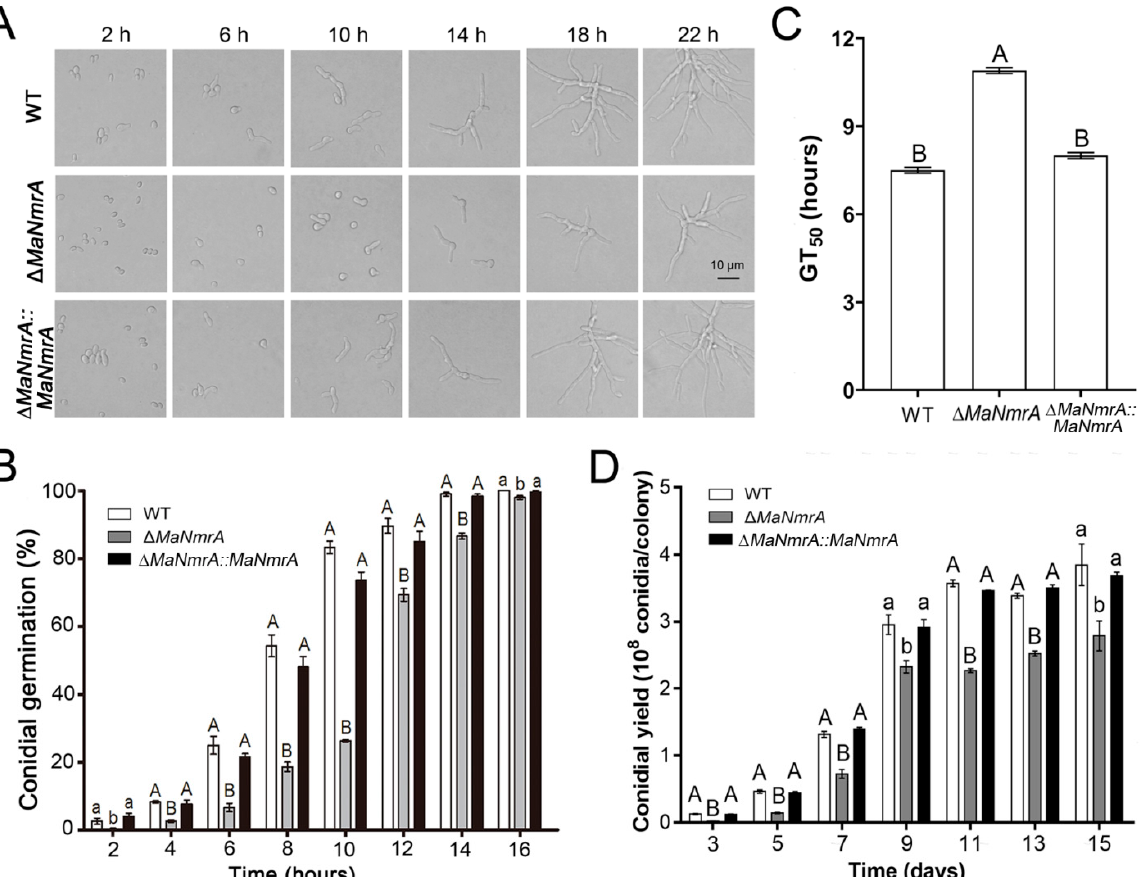
Figure 3. Disruption of MaNmrA delayed conidial germination and reduced conidia production. Growth ( A ), conidial germination rates ( B ), GT 50 s ( C ), and conidial yield ( D ) of the WT, Δ MaNmrA, and ∆ MaNmrA :: MaNmrA strains grown on 1 / 4 SDAY media at 28 °C for different hours or days. Letters A, B, a and b above graph were used to shown the significant difference. a and b, p < 0.05. A and B, p < 0.01 (Tukey’s HSD).